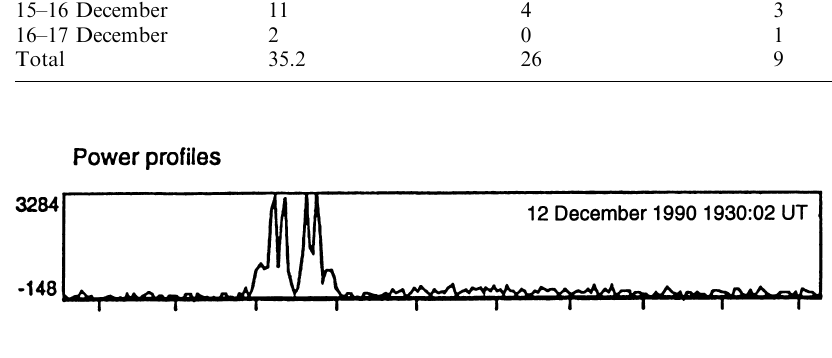
Fig. 3. 2-s integrated raw electron density altitude profiles containing meteor head echoes from the EISCAT UHF radar. The vertical axis give the dynamical range of the signal. The numbers at the upper and lower left corners of each panel refer to this range. The background noise level is subtracted from the signal. The horizontal lines in the lower part of each panel indicate the zero levels. The echoes are seen only in isolated 2-s dumps